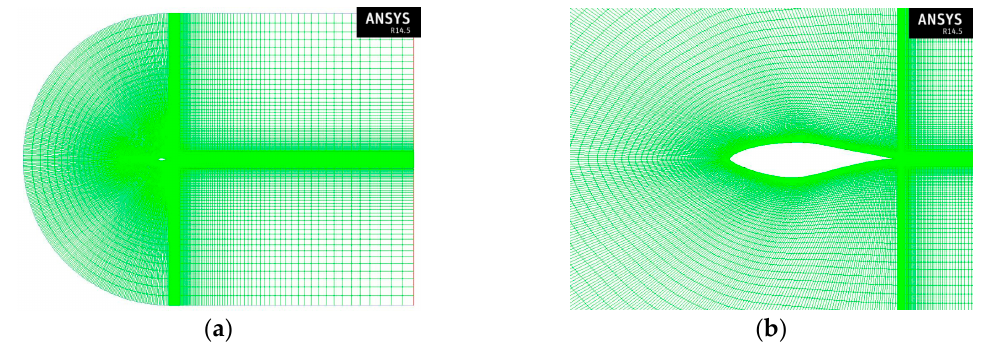
Figure 1. ( a ) C-type grid with 80,000 quadrilateral cells; and ( b ) detail of the mesh close to the S809 airfoil.